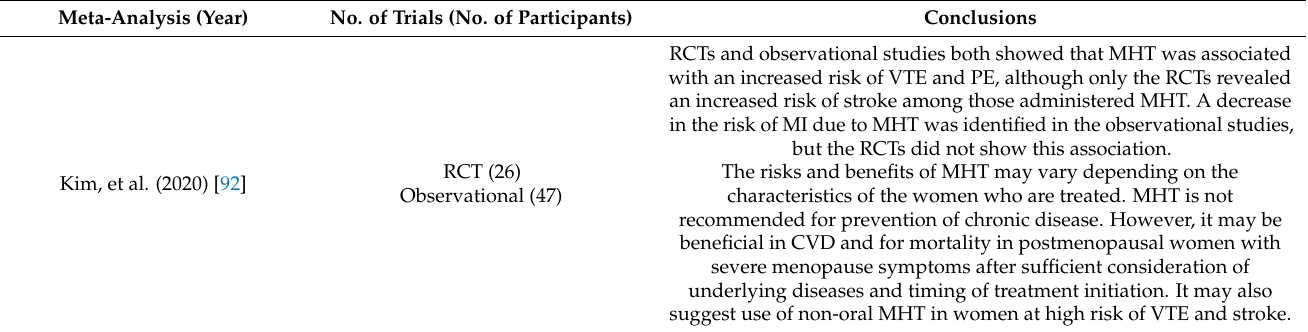
Table 4. Effects of MHT on cardiovascular systems according to the results of several